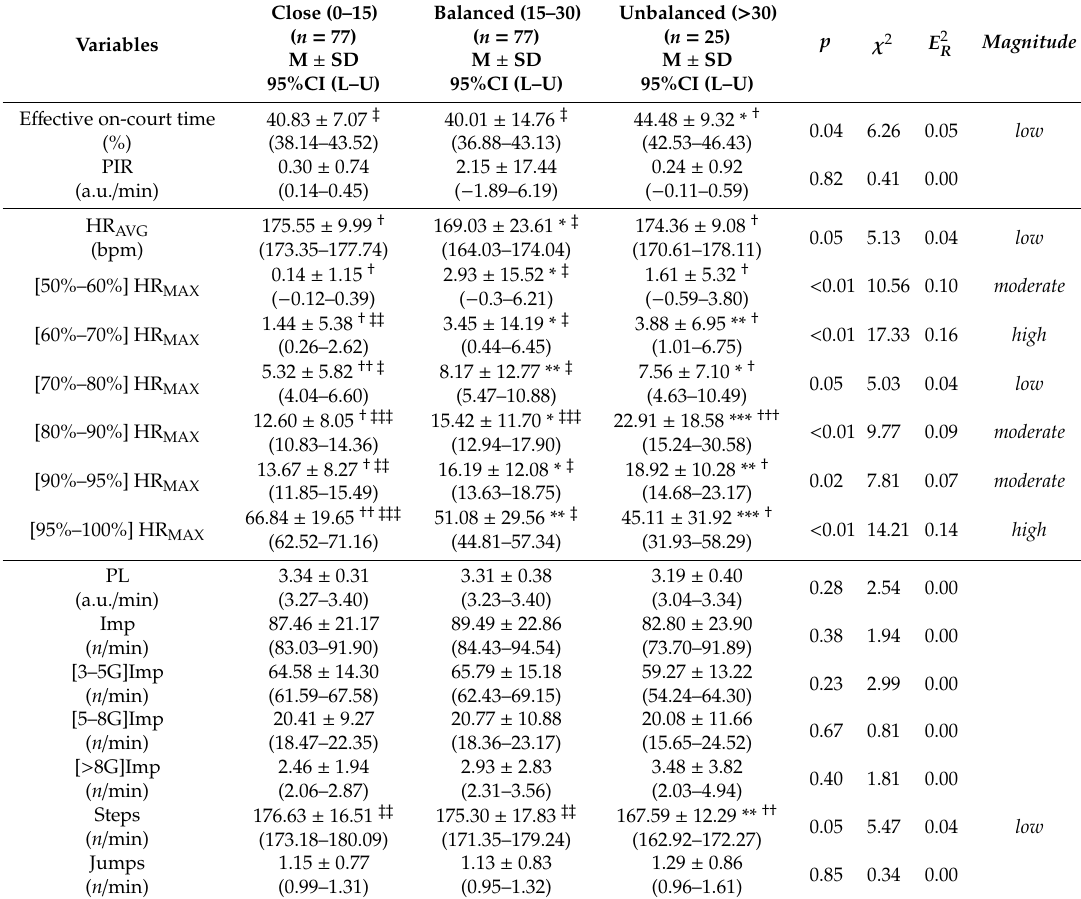
Table 2. Descriptive and inferential analysis of the analyzed variables as a function of the accumulated point di ff erence at the end of the